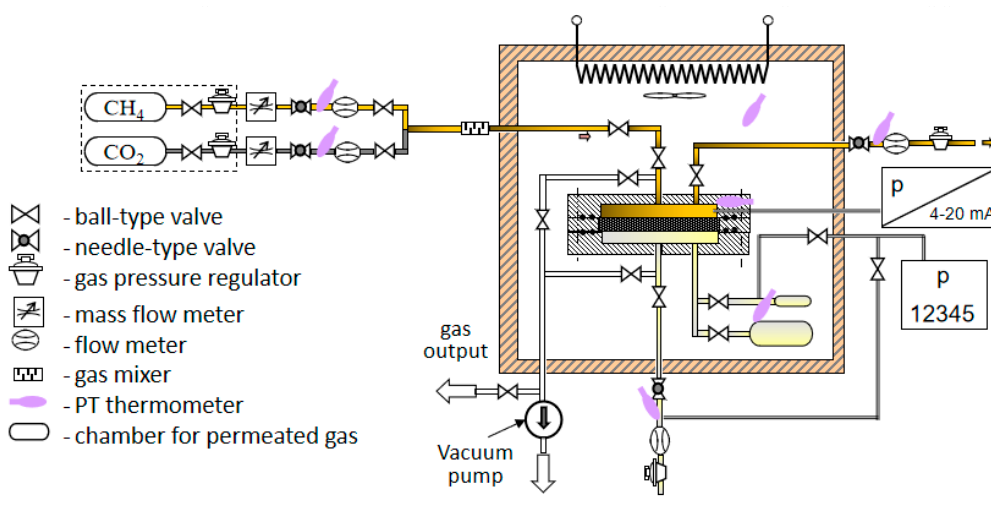
Figure 2. Experimental setup for membrane permeability experiments.